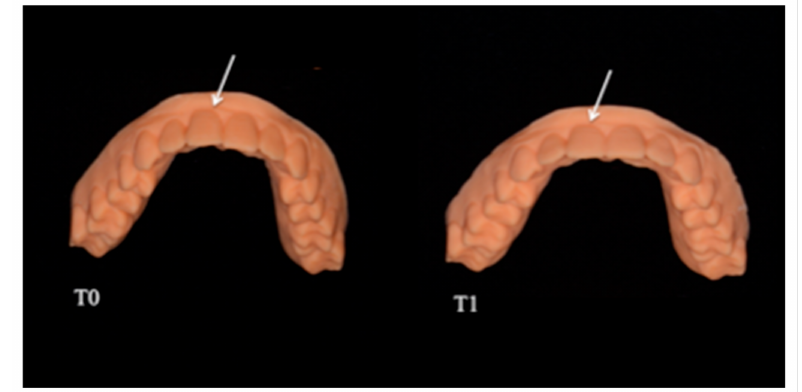
Figure 1. T0 and T1 models. The white arrows indicate the analysed element, before and after moving with